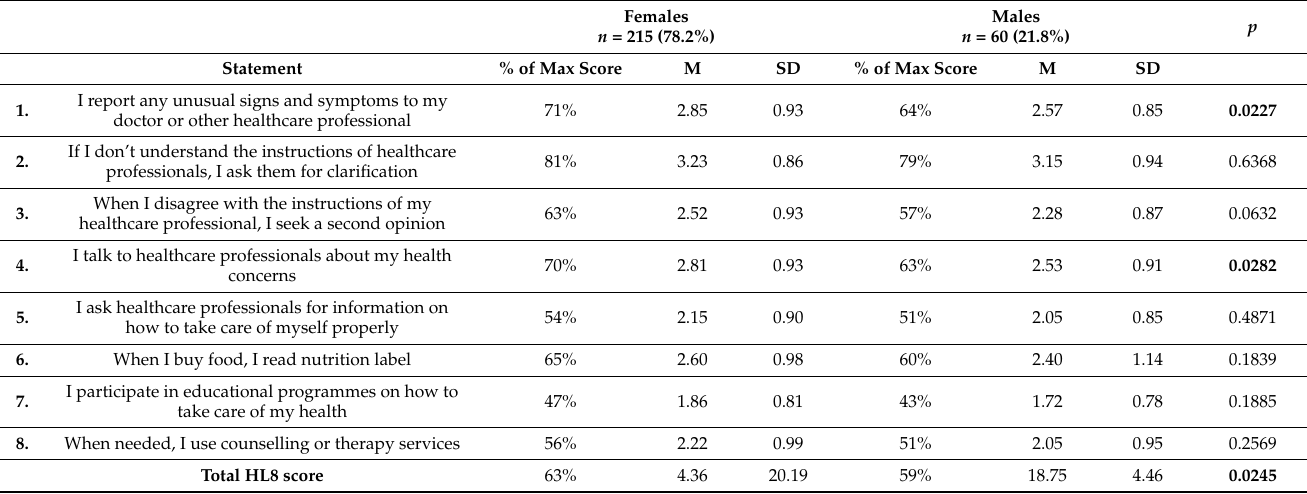
Table 8. Health literacy vs.